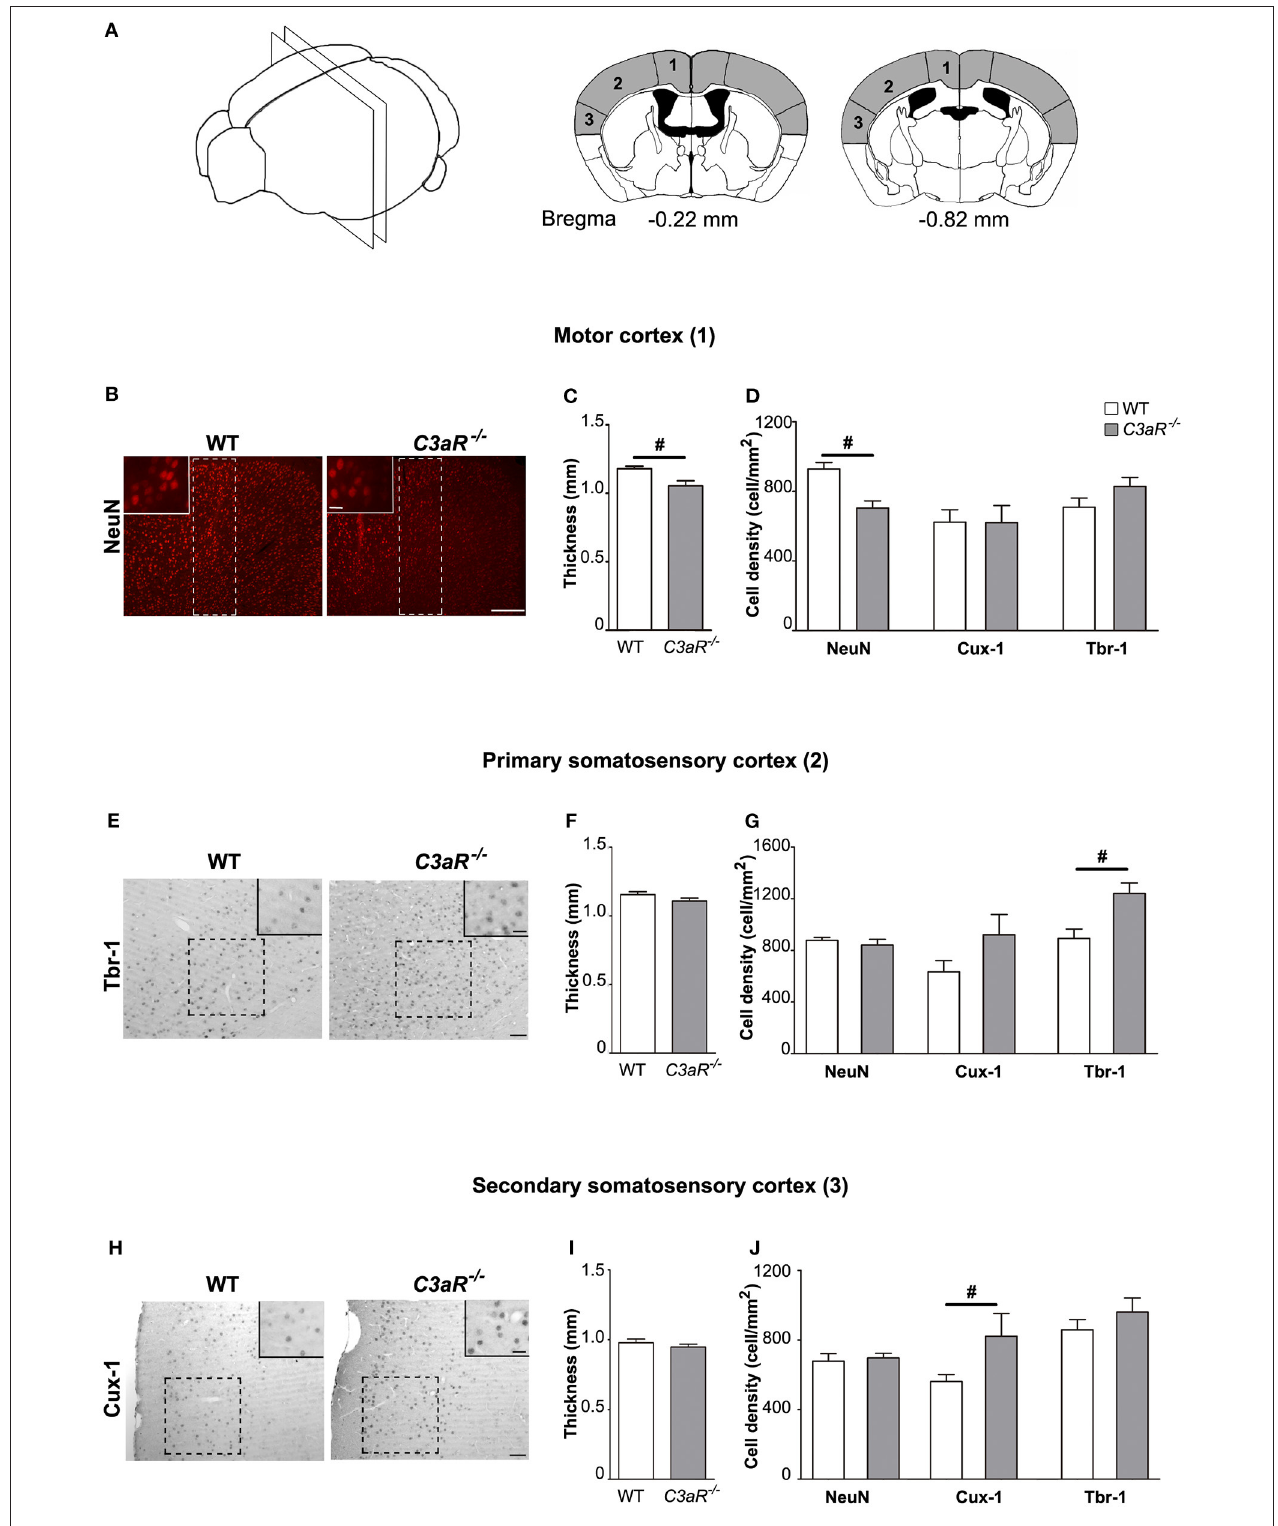
FIGURE 4 | C3aR − / − mice exhibit regional alterations in cortical morphology. Morphological assessment of the thickness of the positive cell layer and the density of NeuN positive, Cux-1 positive, and Tbr1 positive cells in the caudal motor and somatosensory cortex. (A) Schematic illustration of the cortical regions